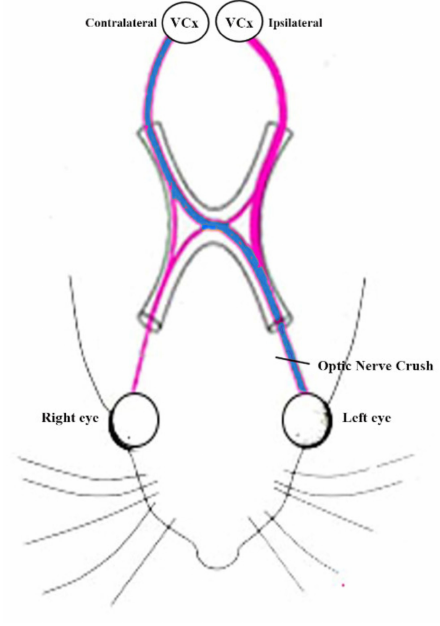
Figure 7. Unilateral optic nerve